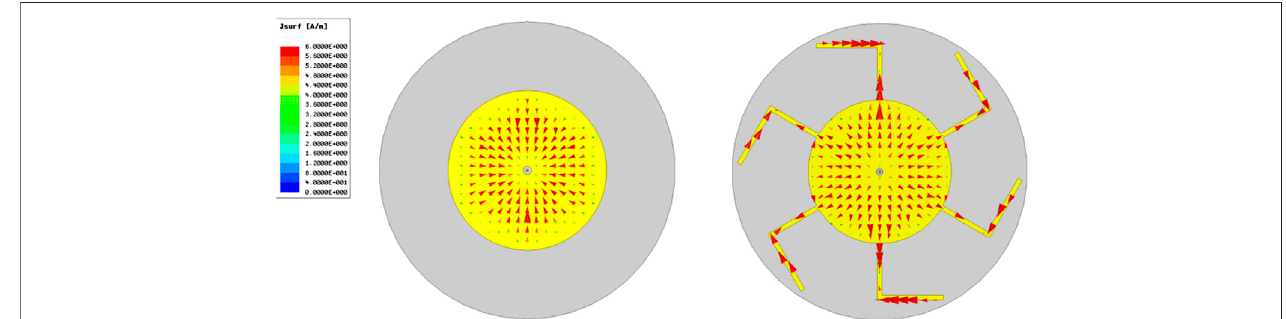
FIGURE 2 | Simulated current distribution on the lower circular patch and ground plane.